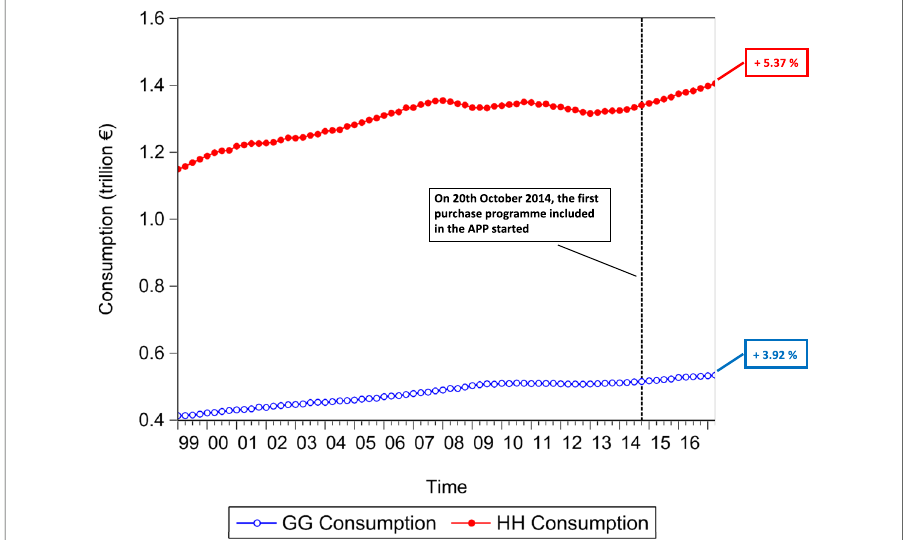
Fig. 15 Household and General Government consumption expenditure; 1999Q1-2017Q2. Time series of the euro area household and general government consumption expenditure, over the reference period 1999Q1- 2017Q2. The vertical line corresponds to the beginning of the first purchase programme (3rd Covered Bond Purchase Programme, CBPP3) included in the APP, started in 2014Q4, while the percentages on the right- hand side of the graph correspond to our estimate of the growth rate of euro area household and general government consumption expenditure, since the initiation of QE. Data source: (European Central Bank